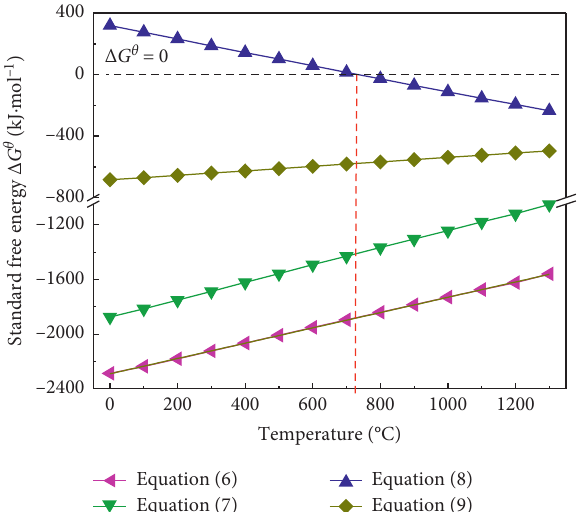
Figure 6: Standard free energy changes for reactions vs. tem- perature for equations (7)–(10).